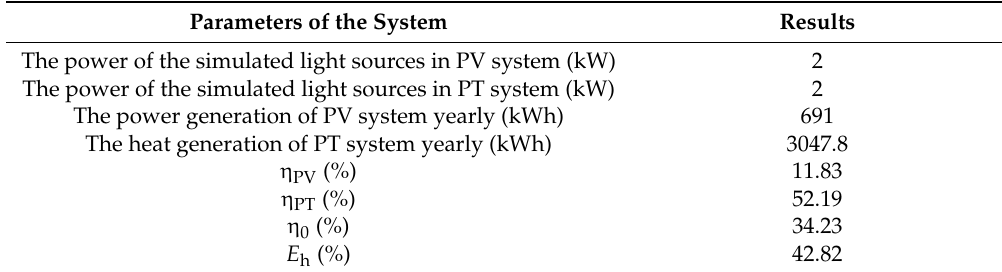
Table 7. Efficiency of the proposed movable hybrid photovoltaic-thermal (PVT) system using the modified equations. Parameters of the System Results